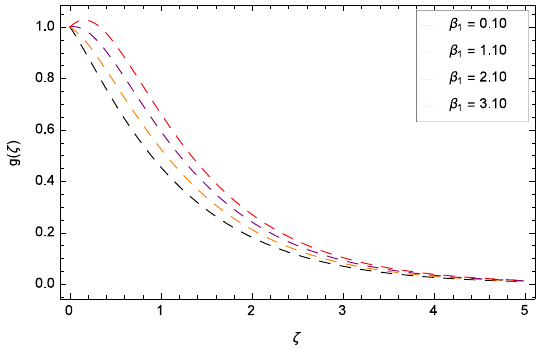
Figure 8. Pattern of graph curves on account of β 1 .